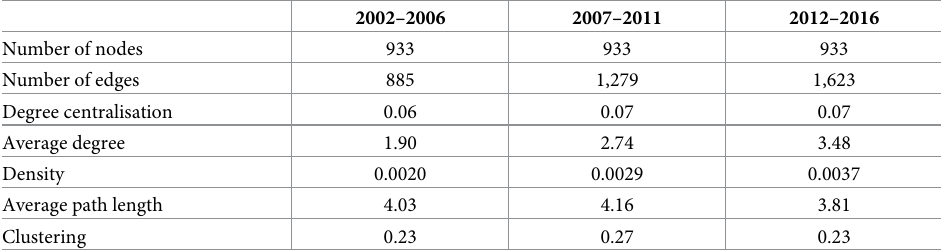
Table 2. Global area SNA indicators in the R&D collaboration network.